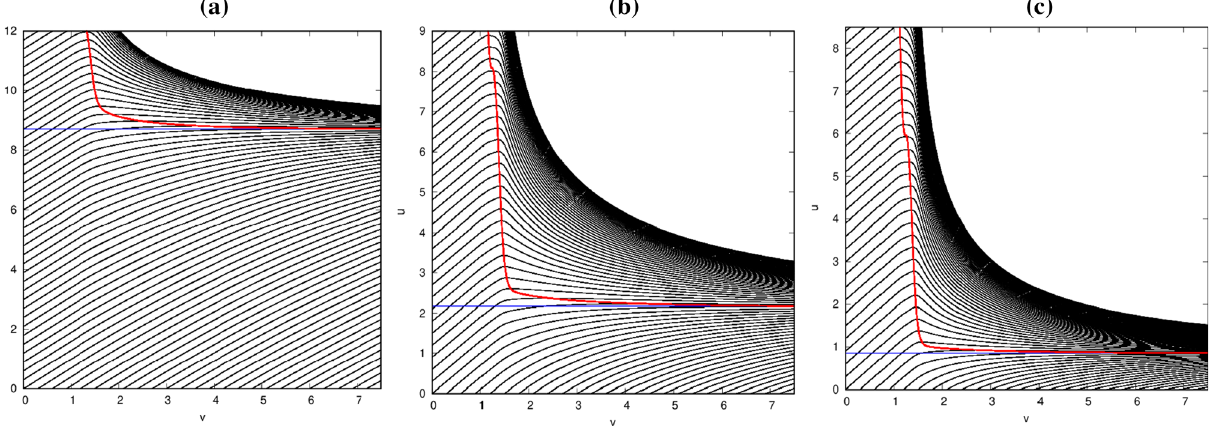
Fig. 4 Penrose diagrams of spacetimes emerging from evolutions with α = − 1 and γ = 1. The field amplitudes ˜ p s = ˜ p h were equal to a 0 . 02, b 0 . 04 and c 0 . 05